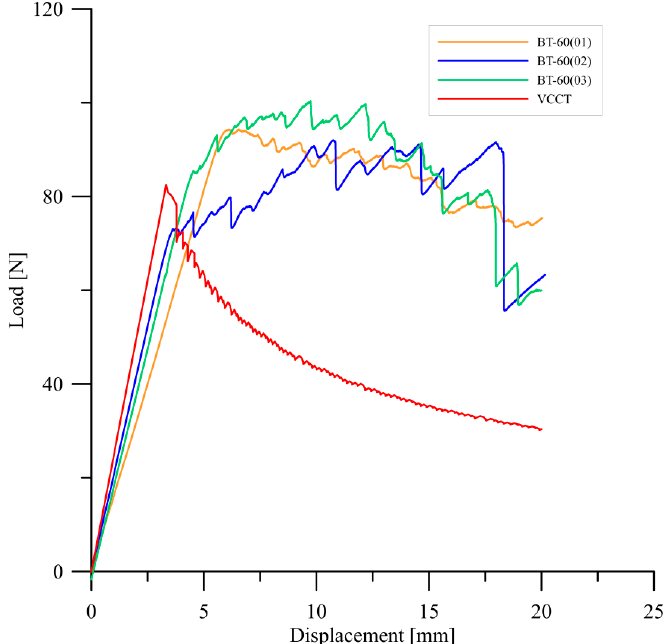
Figure 8. Experimental and numerical load versus displacement plots obtained for the BT60 bending–twisting laminates. Table 4. Values of critical strain energy release rates determined for bending–twisting coupled laminates by using different data reduction schemes.